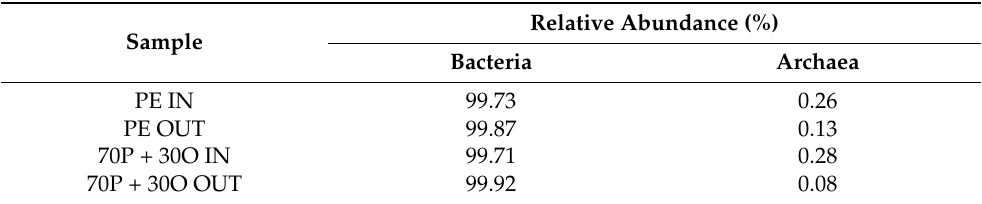
Table 10. Relative abundance of bacteria and archaea domains.